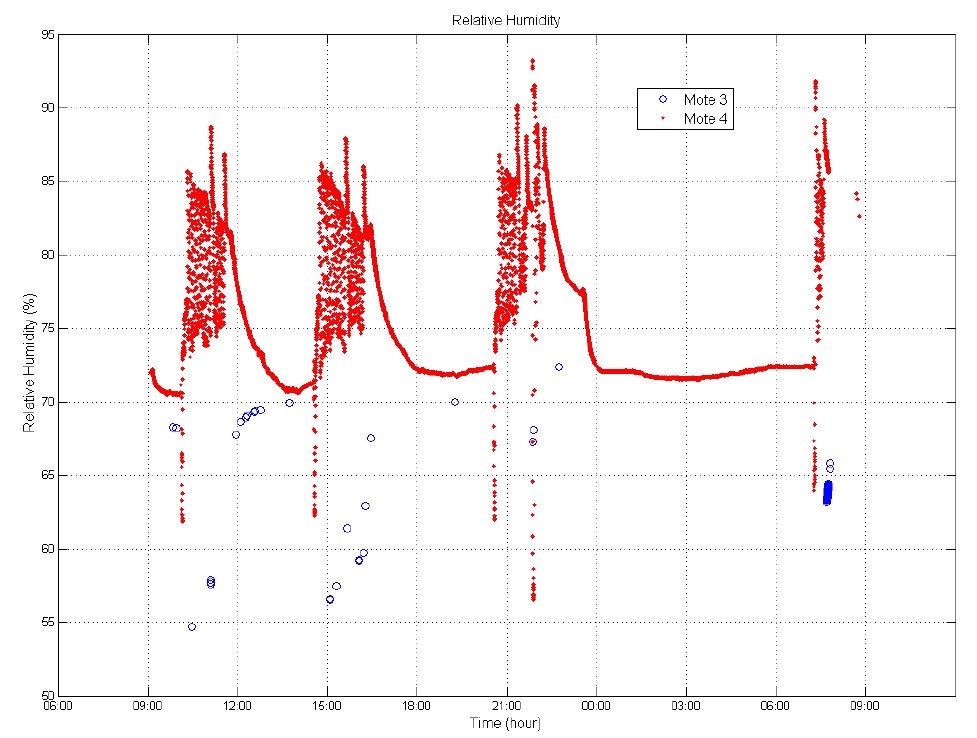
Figure 3. RH comparison between